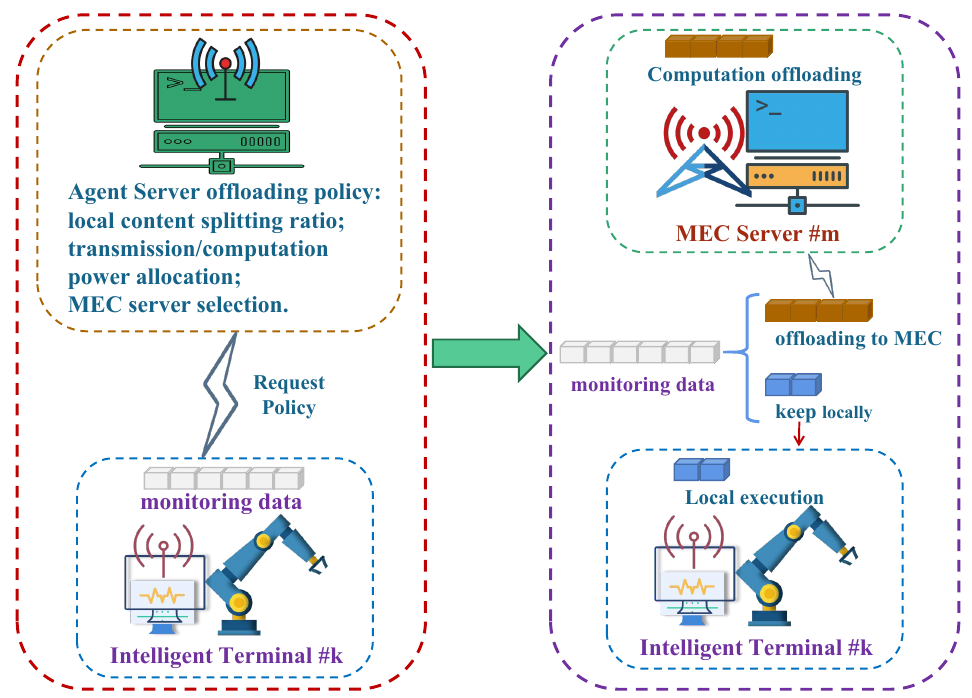
Figure 4. The working principle of intelligent fault diagnosis system in this paper. The intelligent terminal collects the fault diagnosis data and then requests a policy from the agent